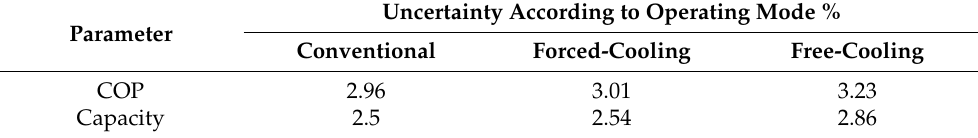
Table 4. Uncertainty analysis of experimental